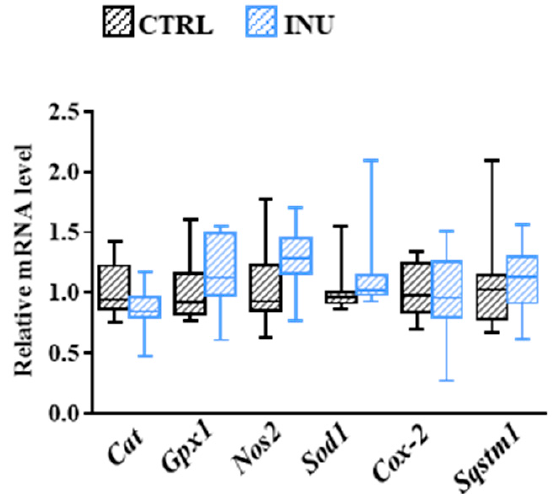
a The percentage of each lyso-phosphatidylethanolamine (LPE) species relative to that of total LPEs (100%) was determined. b Ratio of total LPEs/total ethanolamine glycerophospholipids (PEs, non-plasmalogens). Total LPEs and total PEs were calculated as the sum of the area under the peak of each species corrected with that of the internal control (PE(28:0)). Data are expressed as mean ± SEM. * p < 0.05. Mann–Whitney test for comparison of the abundance of LPE species or LPEs/PEs between CTRL and INU mice. SEM, standard error of the mean.